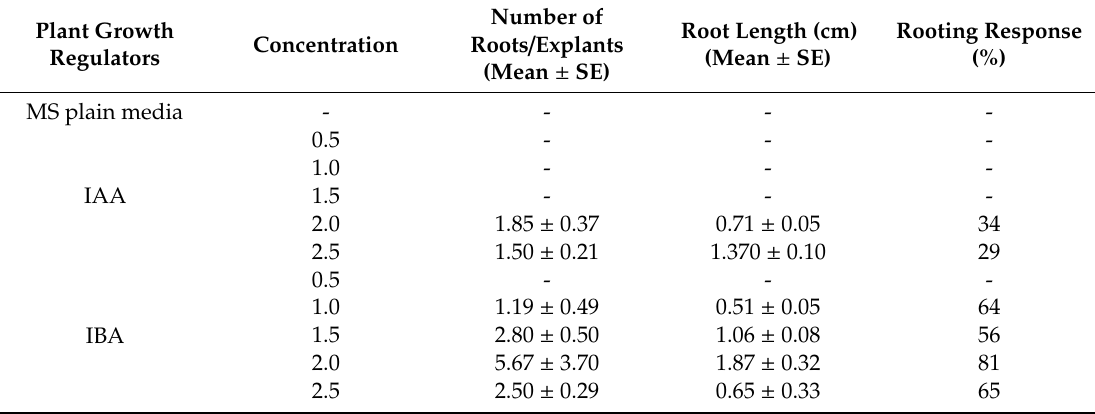
Table 3. In vitro root induction from callus-induced shoots as influenced by IAA or IBA. Plant Growth